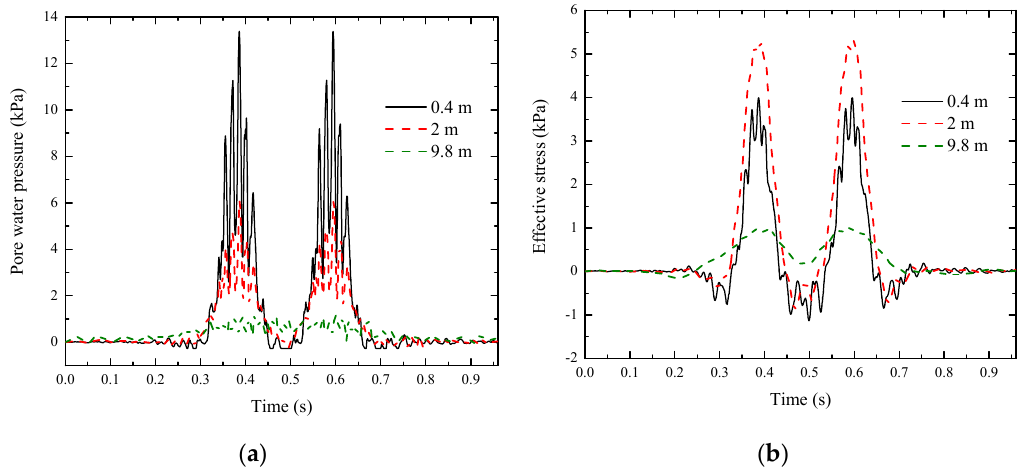
Figure 8. Time history curves of saturated ground: ( a ) Pore water pressure and ( b ) effective stress.